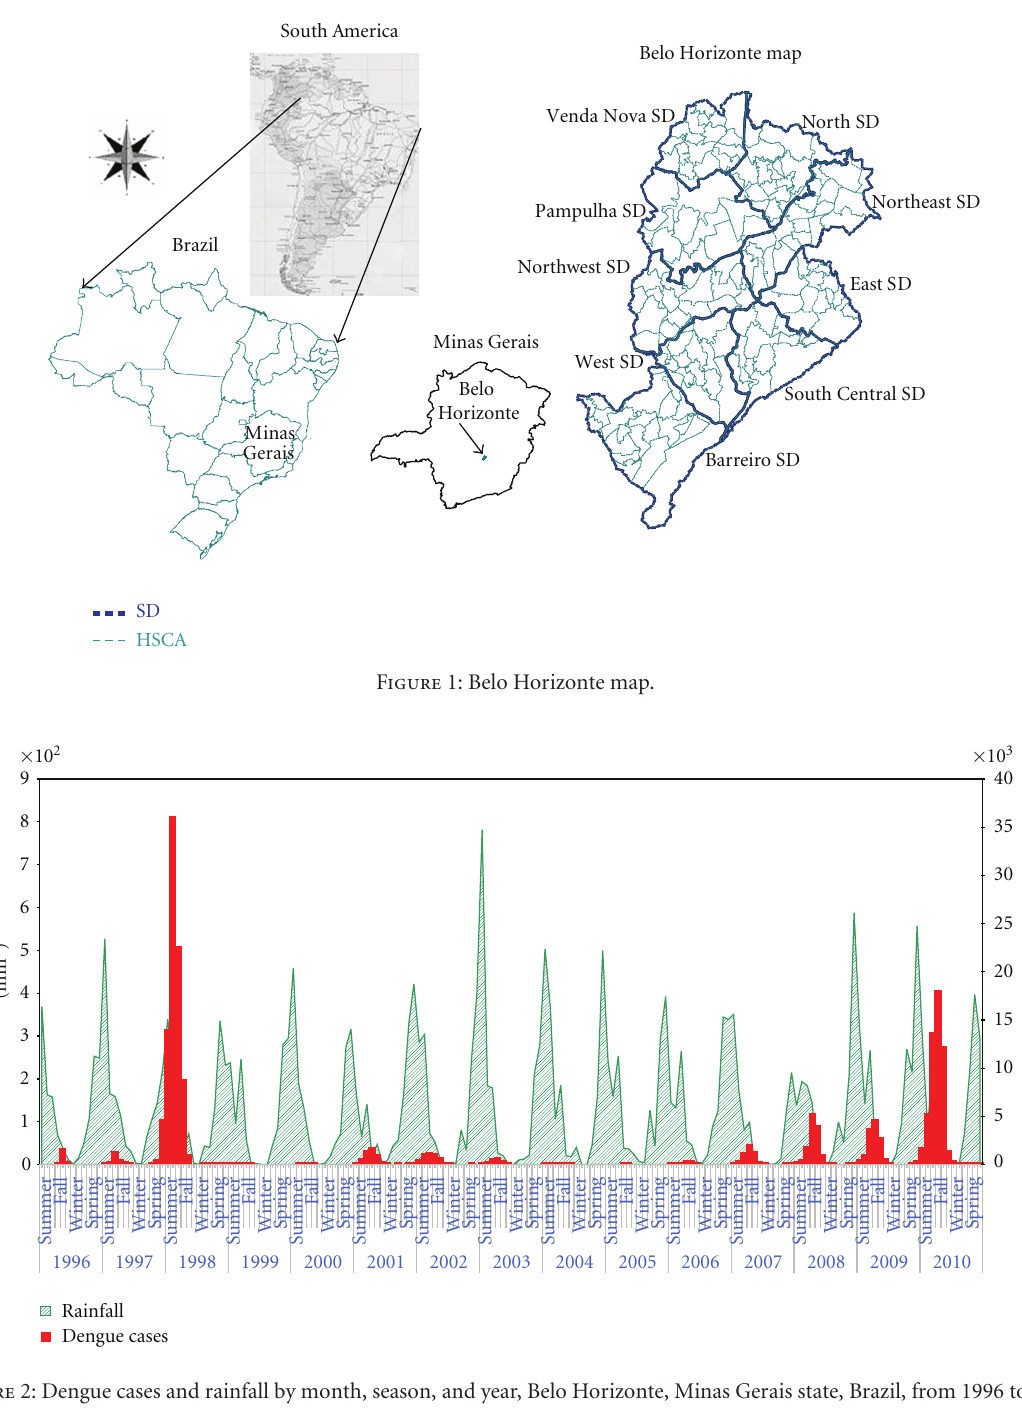
The first dengue epidemic in Belo Horizonte (BH),